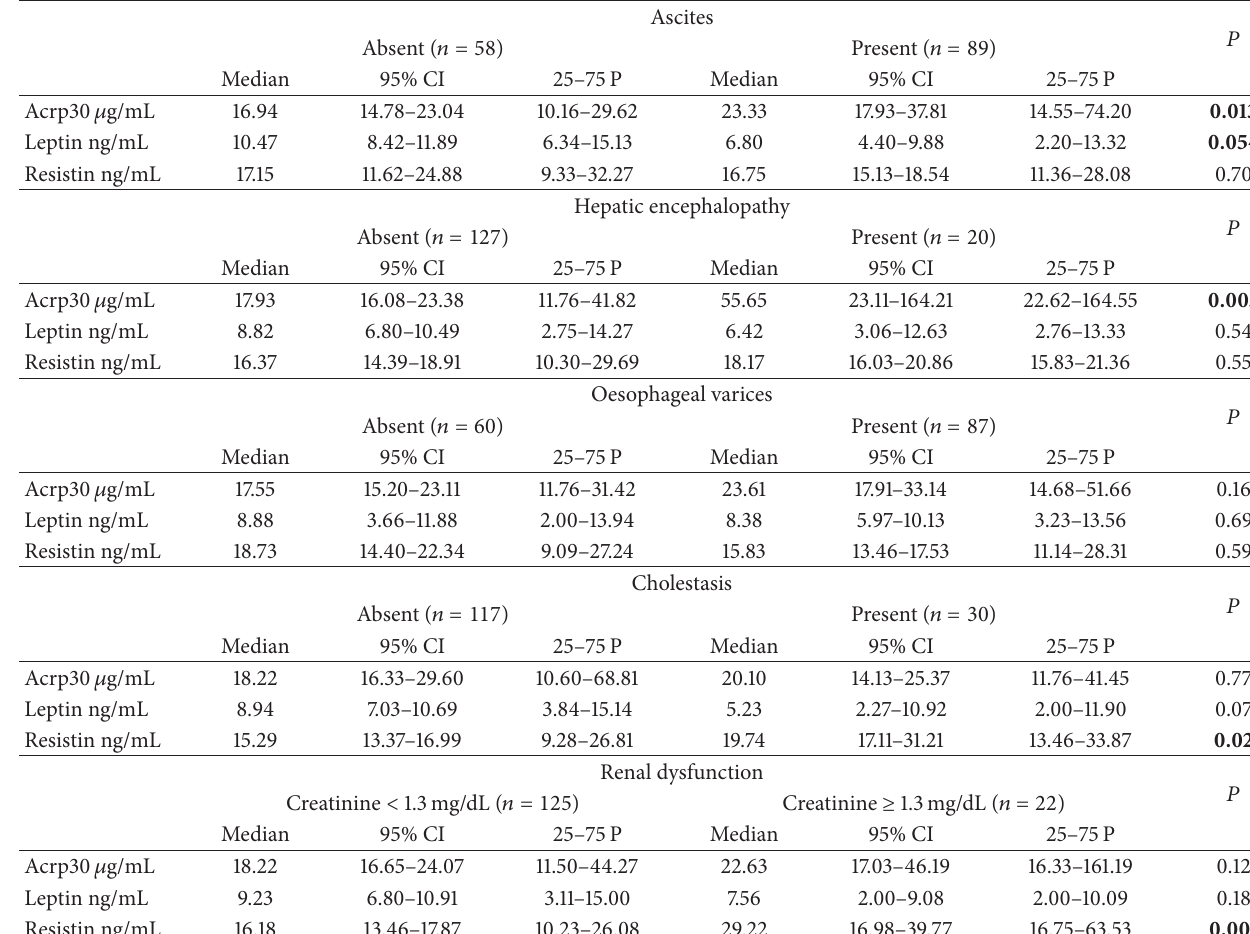
Table 10: Serum adipokine levels in patients with ALD according to the presence of the disease complications. Ascites Absent ( 𝑛 = 58